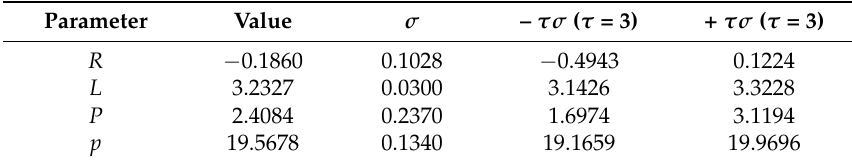
Table 2. Results of the analysis of the vertical displacement of point GB/6.